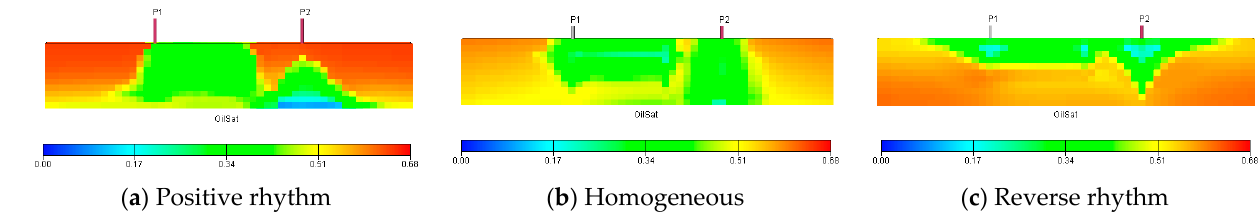
Figure 9. Viscosity distribution diagram after well stuffy.